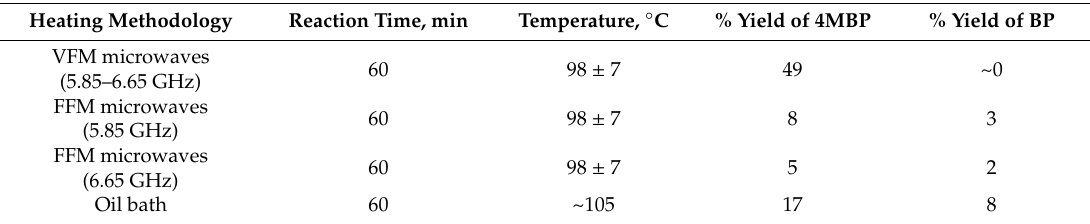
FFM microwaves (6.65